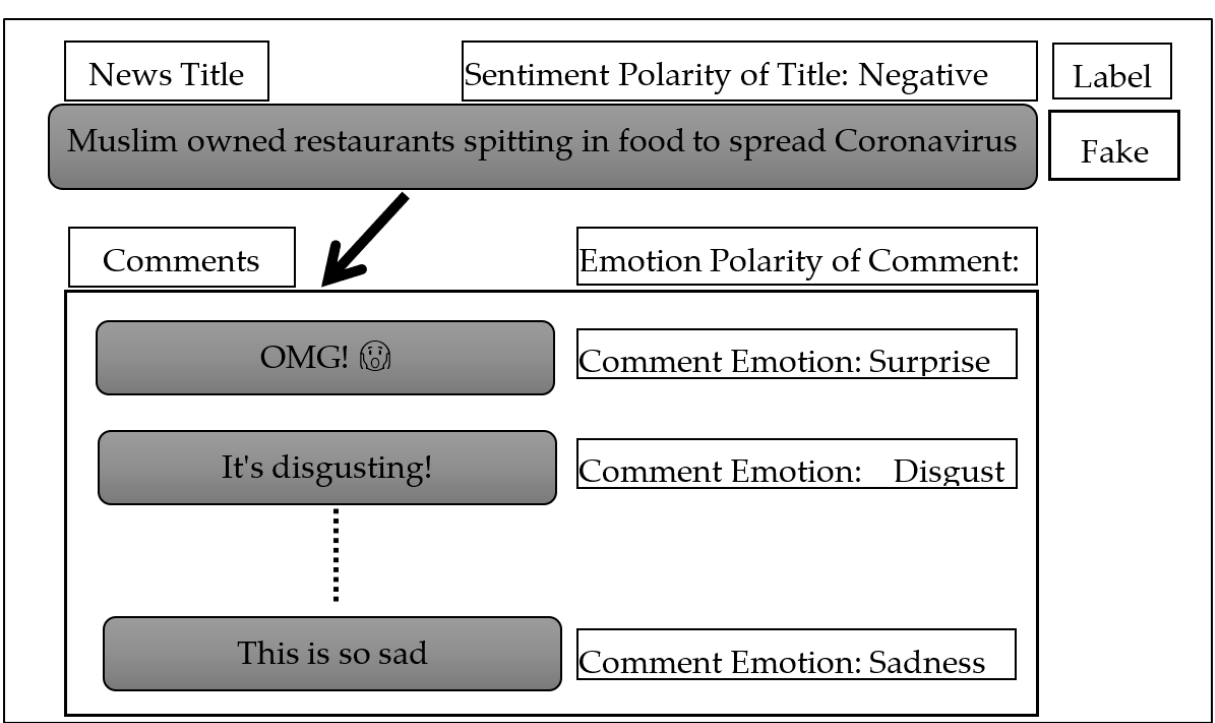
Figure 1. The sentiment analysis of fake news and emotion analysis of the public’s comments about fake news, (These comments are the reaction of the users toward the title of the posted news).